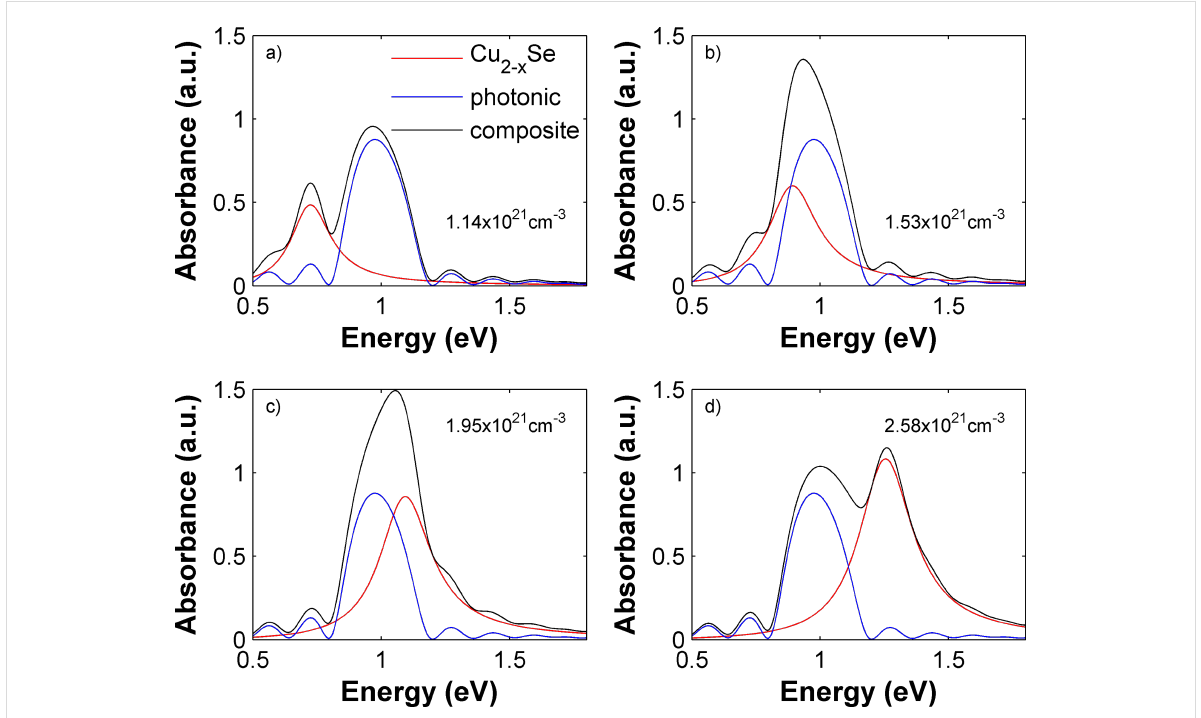
Figure 3: Absorption properties of a Bragg mirror (blue curves) coupled to a dispersion of Cu 2 − x Se NCs (red curves) for different carrier concentra- tions of a) 1.14, b) 1.53, c) 1.95 and d) 2.58 × 10 23 cm − 3 . The black curves illustrate the optical properties of the coupled